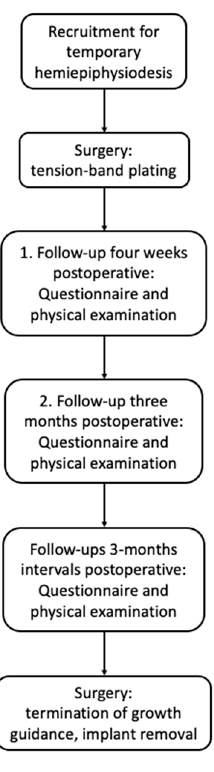
Figure 1. Flow chart of the study design.